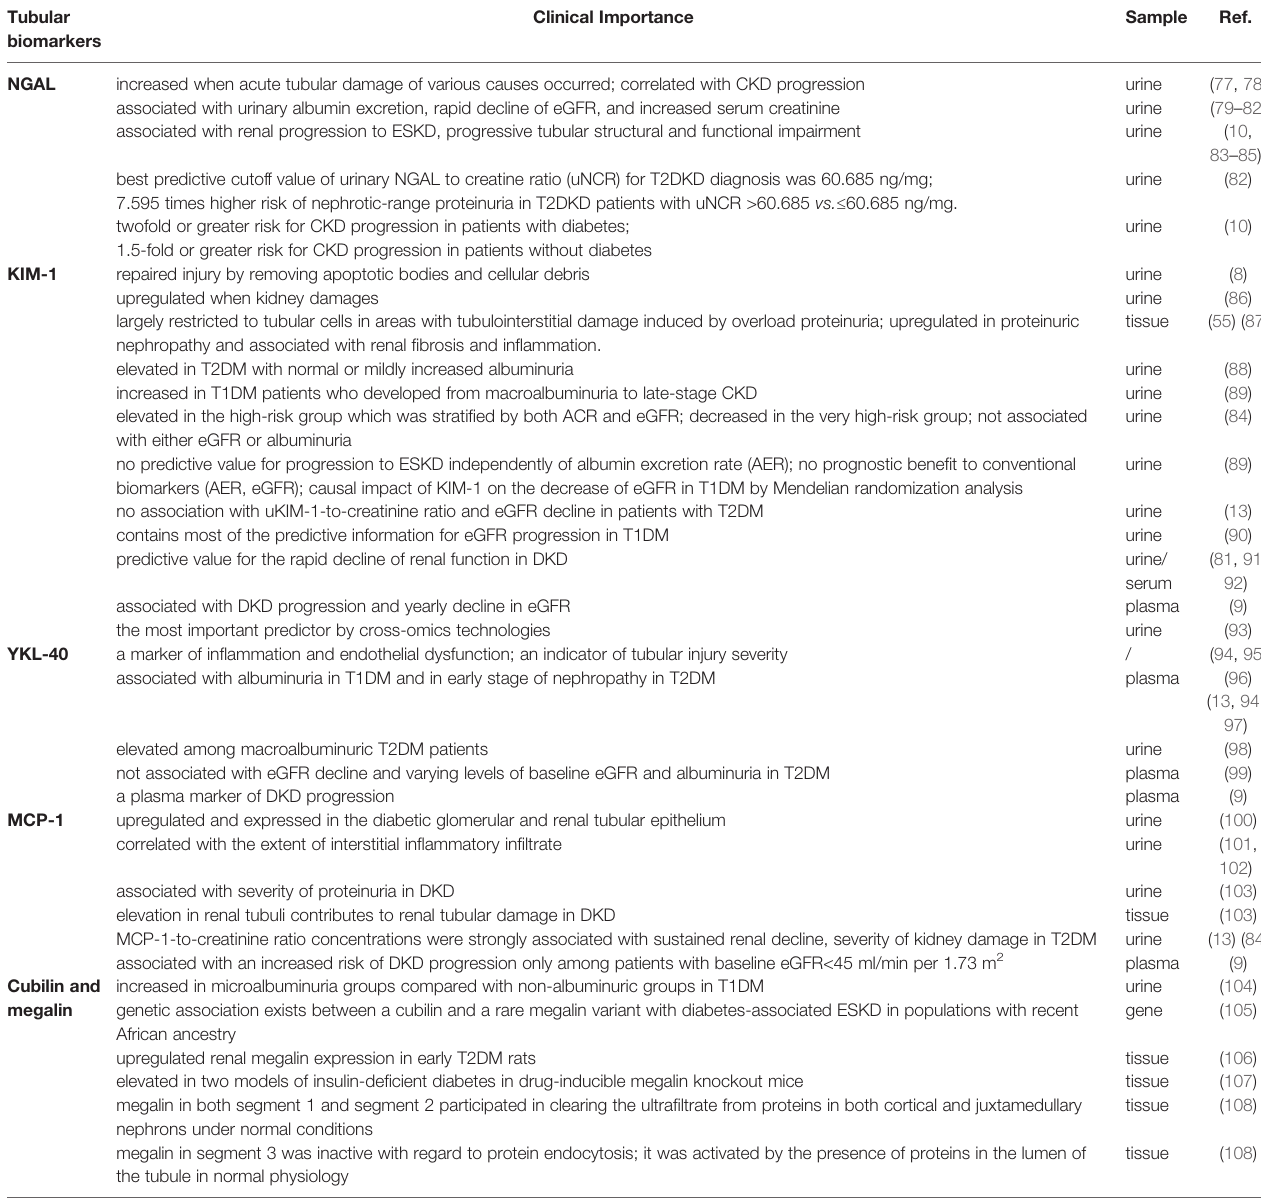
TABLE 1 | Summary of principal tubular biomarkers of DKD in clinical